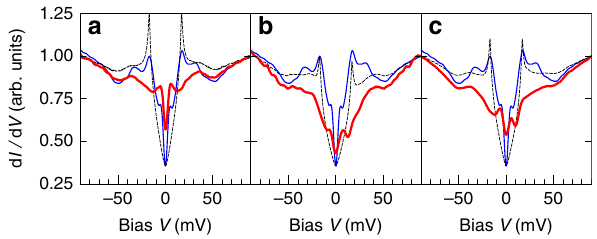
Figure 4 | The subgap states survive the loss of coherence. The thick red curves show the tunnelling conductance measured at T ¼ 0.4K in ( a ) a vortex core (6T field), ( b ) at a twin boundary (zero field) and ( c ) in a non- superconducting region (zero field). The thin blue lines show a typical averaged zero-field spectrum. The dashed lines show that the model (1) with the red curve as N 0 ( x ) is inconsistent with the zero-field data; a constant was added to match the zero-bias conductance at zero-field. All curves are normalized to unity at the right edge of the